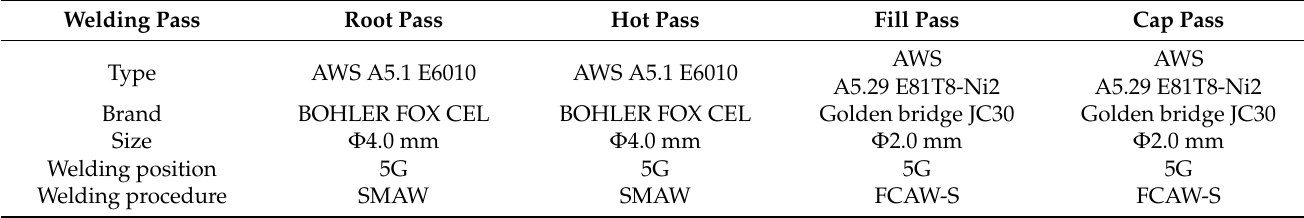
Figure 1. Weld profile measured from the macro of GW 1. Table 1. Welding material and the procedures.